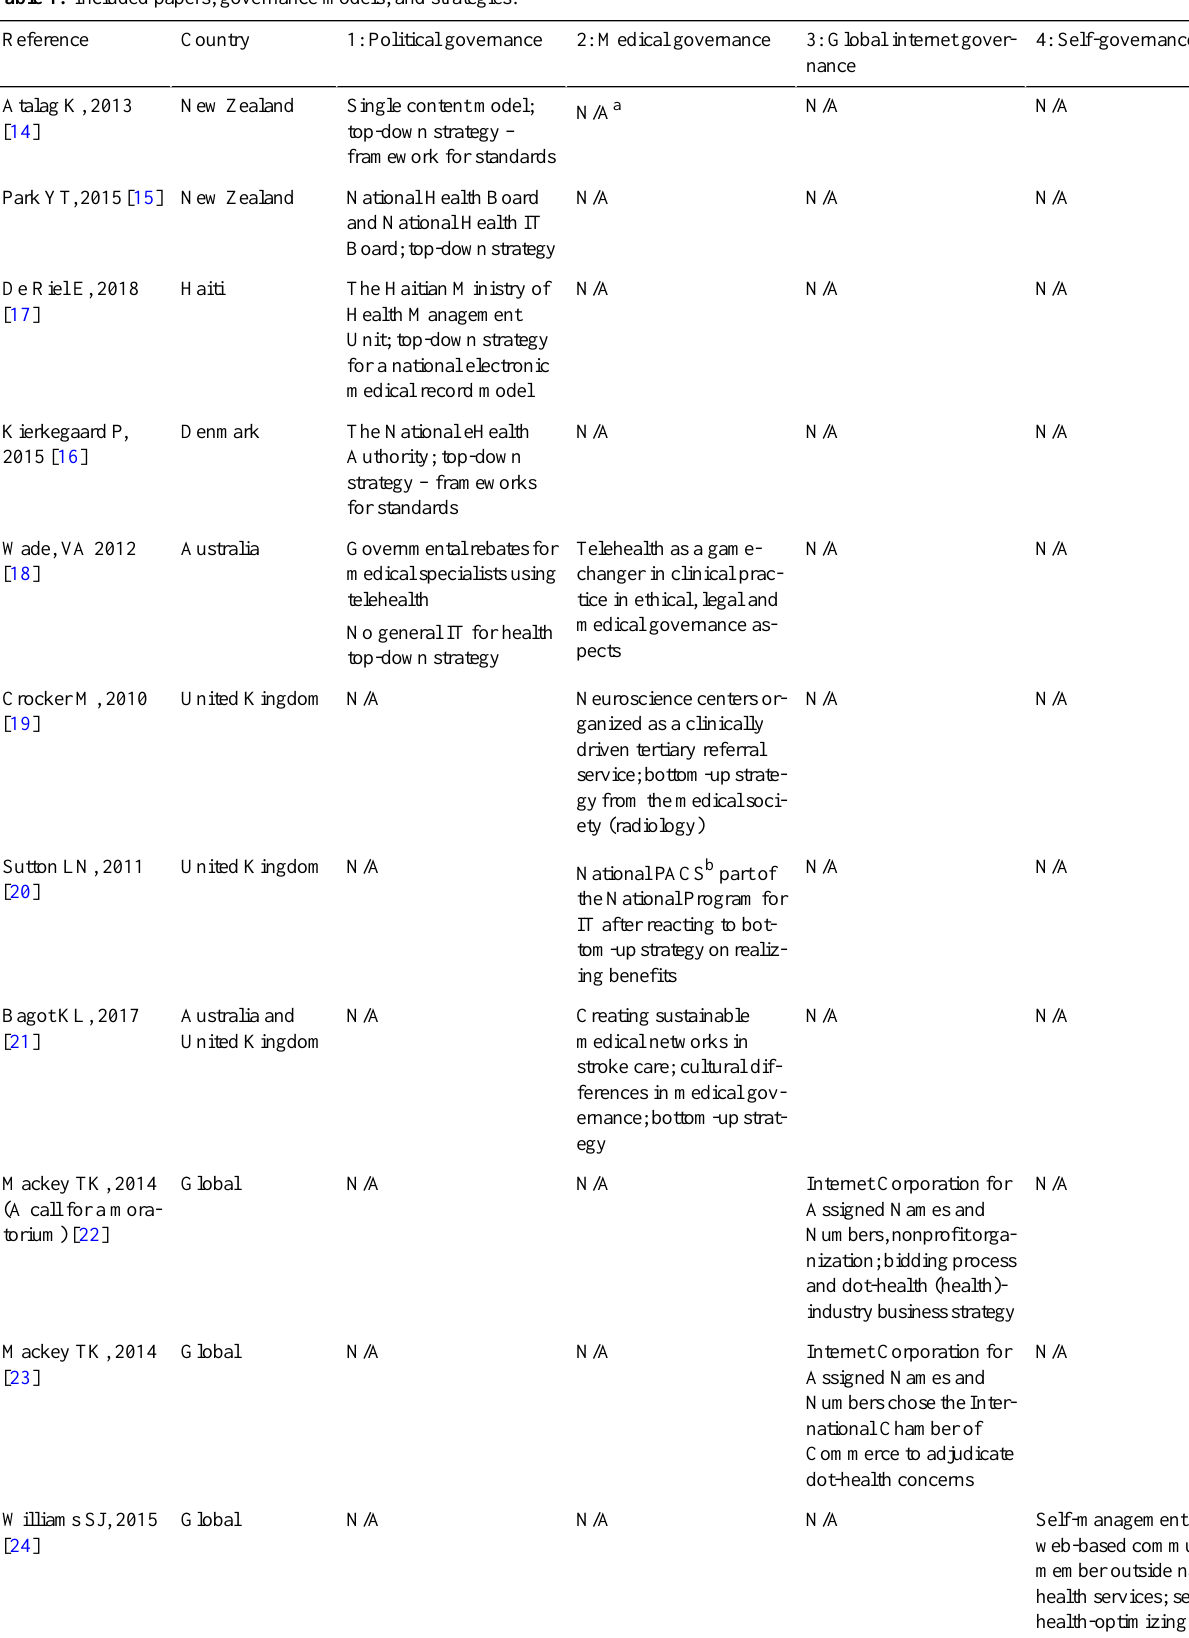
Table 1. Included papers, governance models, and